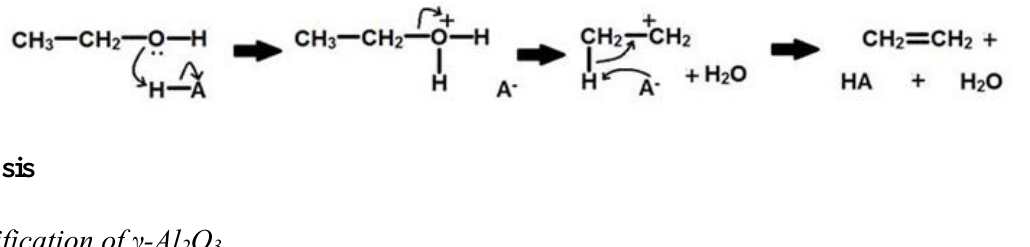
Figure 3. Mechanism for the dehydration of ethanol to